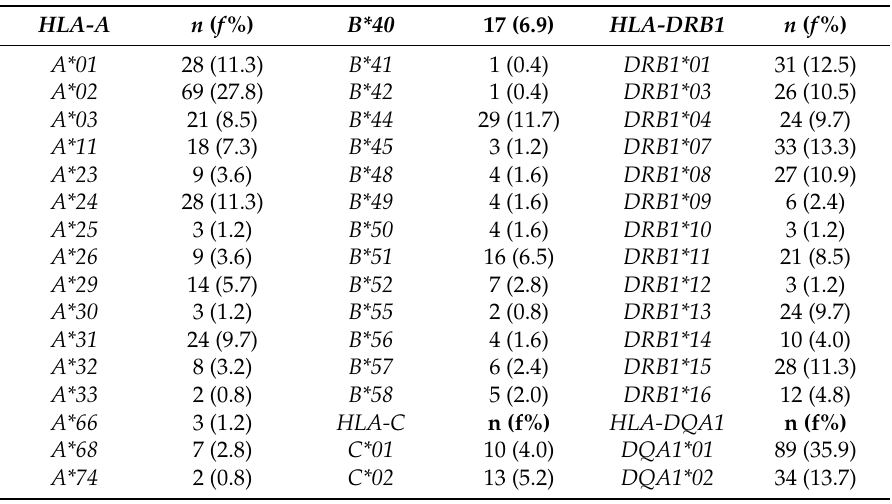
Table 2. HLA class I and II allele types in the study population ( n =